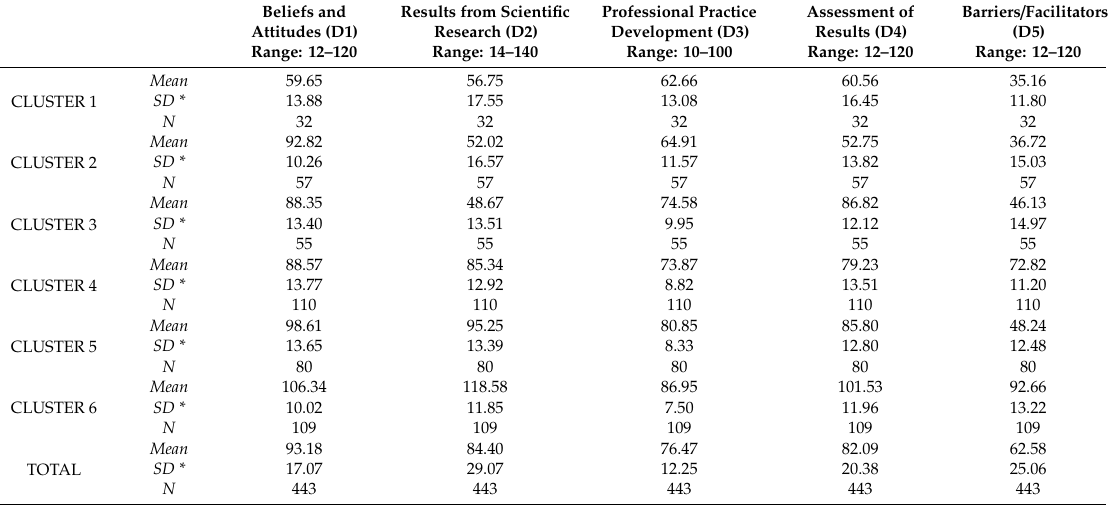
Table 4. Description of Clusters across the HS-EBP latent